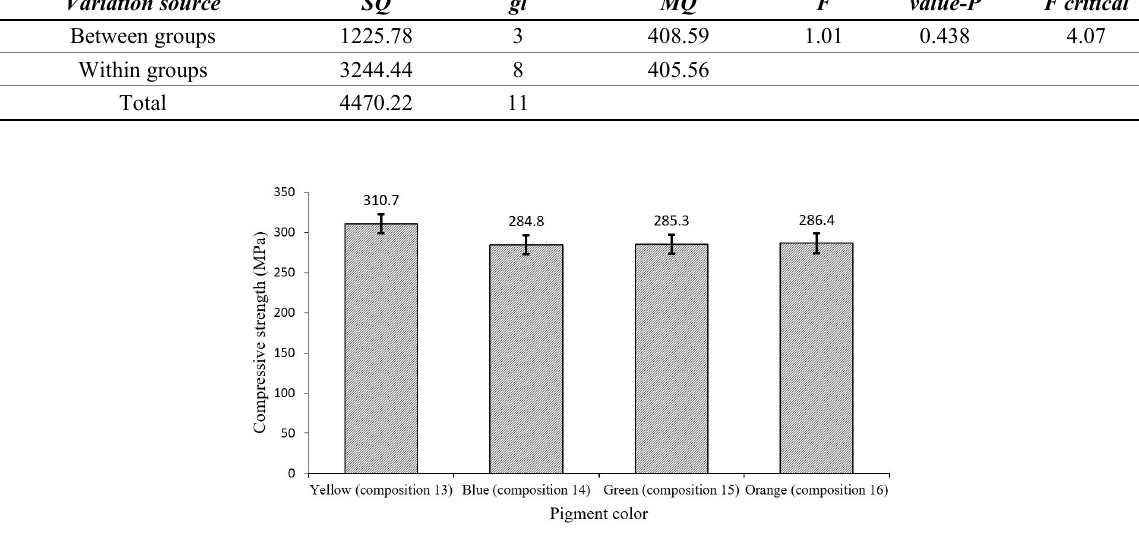
Figure 6. Influence of type of pigment in RCP compressive strength – Phase